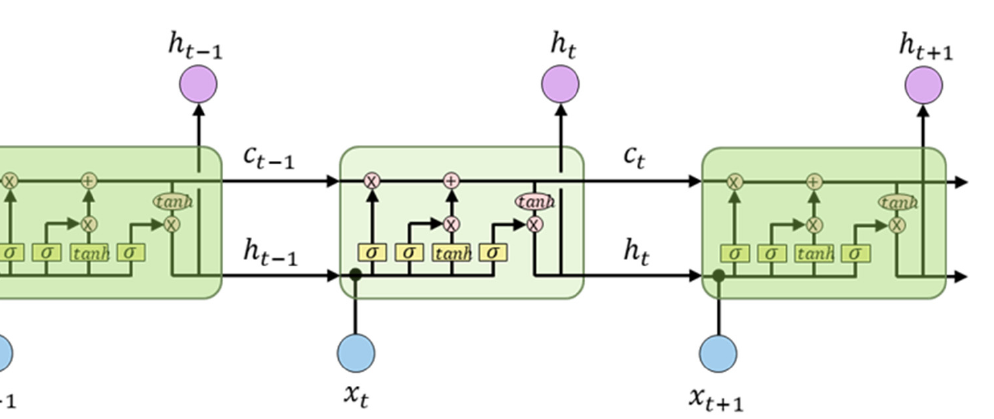
Table 4. Hidden layer and hidden unit settings for MLP-based anomaly detection models. The Number of Model